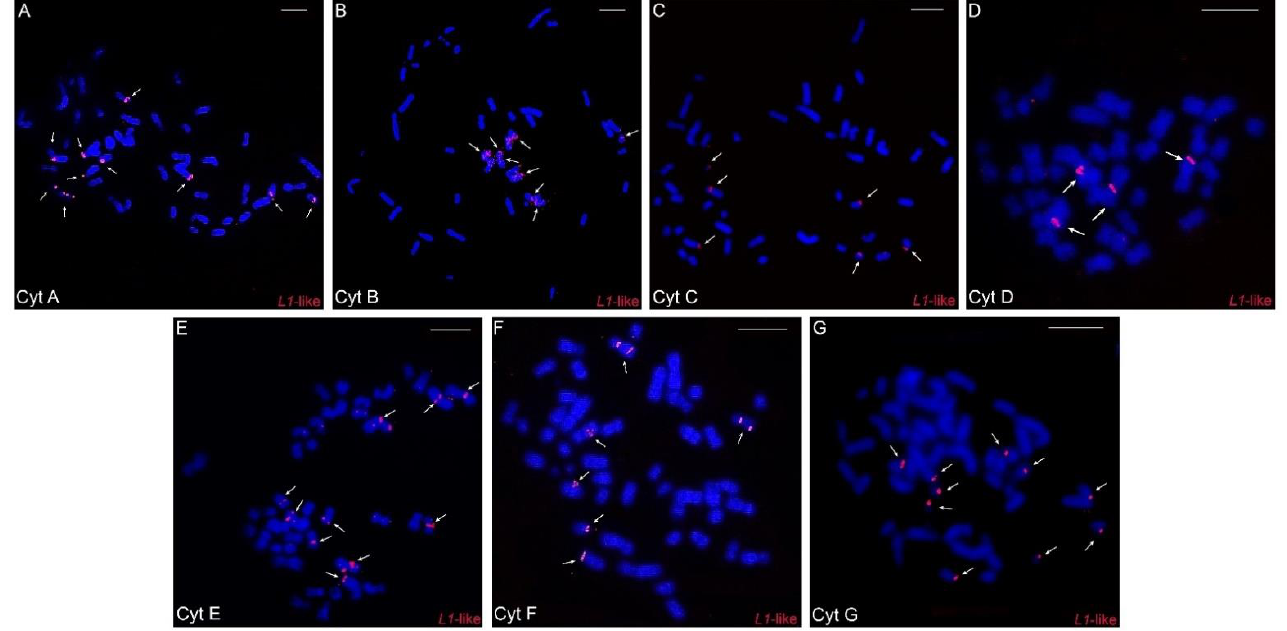
Figure 5. Fluorescence in situ hybridization experiments with the LINE-1- like probes in the different cytotypes ( A – G ) of Ctenomys minutus . The arrows indicate the LINE-1 -like hybridization signals. Bar = 10 μm .